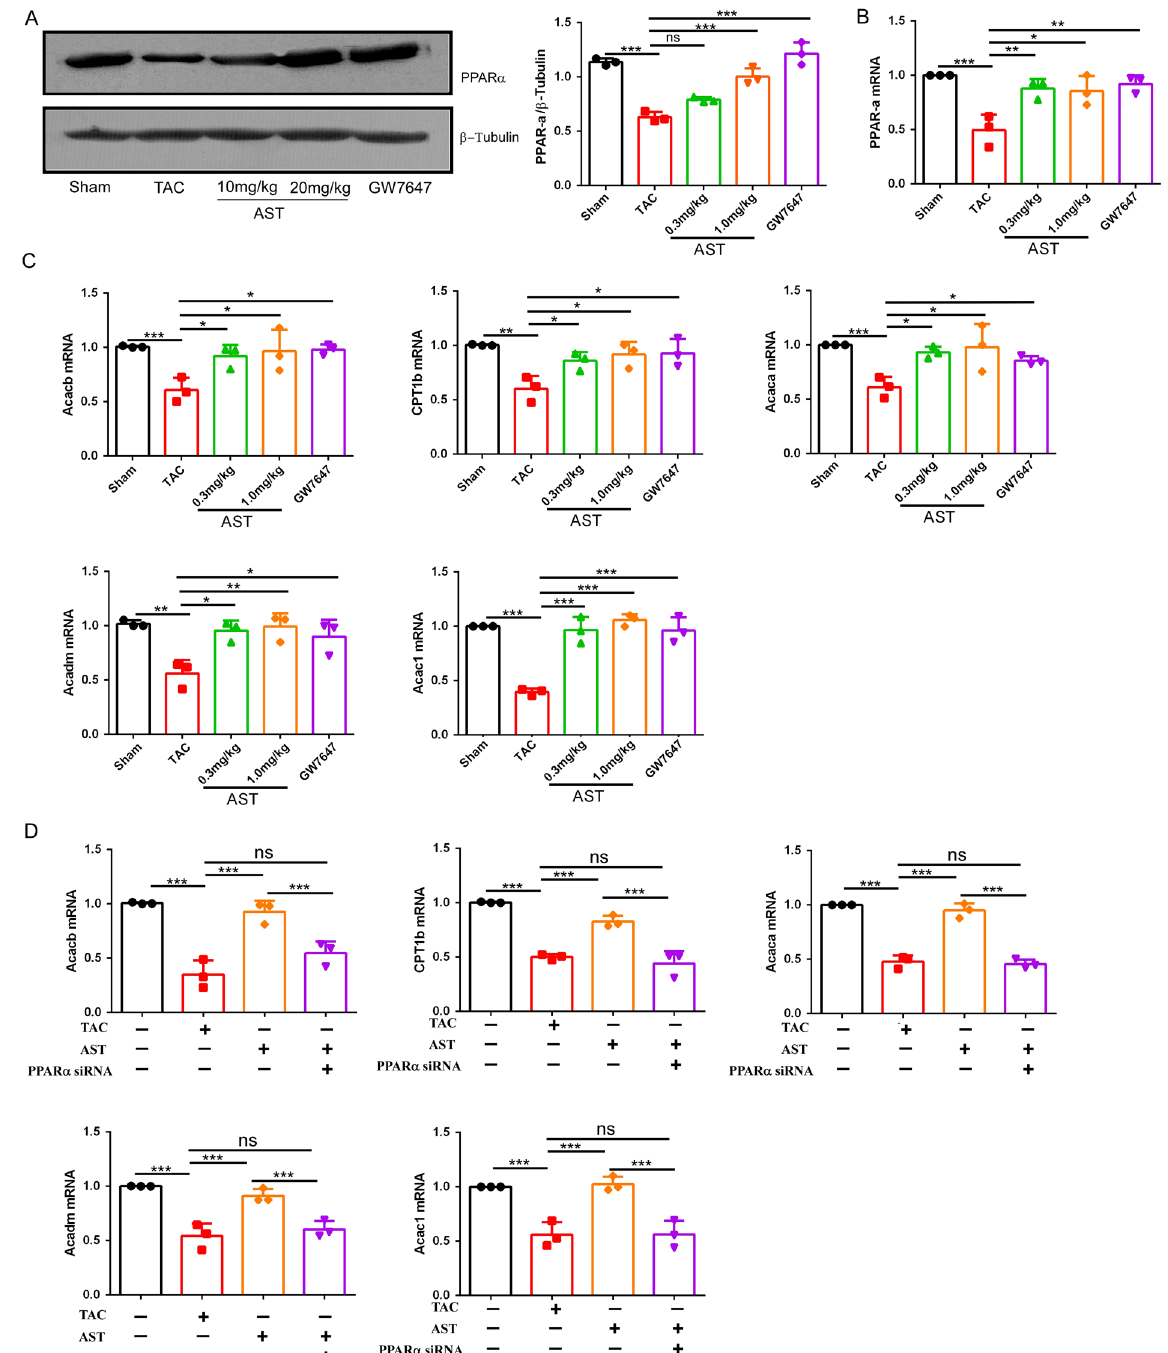
Figure 2. Astragaloside IV modulated PPAR α and PPAR α -targeted genetic expression in transverse aortic constriction-induced heart failure. ( A ) Western blotting analysis of PPAR α expression. * P < 0.05, ** P < 0.01 and *** P < 0.0001 (n = 4). The original gels images used for A are shown in Supplementary Fig. S1. ( B ) Quantitative real-time polymerase chain reaction (RT-PCR) analysis of PPAR α gene expression. * P < 0.05, ** P < 0.01 and *** P < 0.0001 (n = 4). ( C ) and ( D ) Quantitative RT-PCR analysis of the expression of the PPAR α -targeted genes Acaca, Acacb, Cpt1b, Acacm, and Acac1. Acaca: acetyl-Coenzyme A carboxylase alpha; Acacb: acetyl-CoA carboxylase beta; Cpt1b: carnitine palmitoyltransferase 1B; Acadm: Acyl-CoA Dehydrogenase, C-4 To C-12 Straight Chain; Acac1: acetyl-CoA carboxylase 1. * P < 0.05, ** P < 0.01 and *** P < 0.0001 (n = 5). Data are mean ±